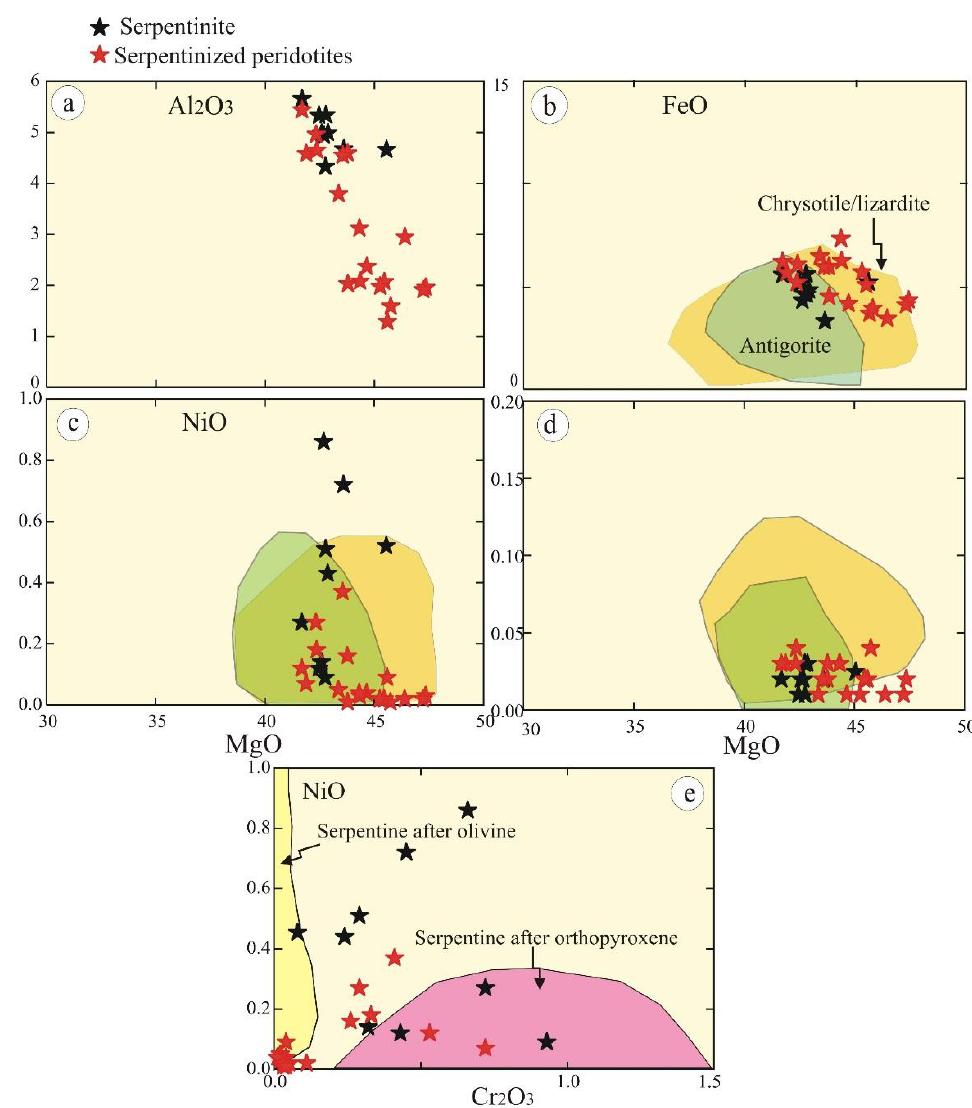
Figure 6. Serpentine binary variations: ( a ) MgO vs. Al 2 O 3 ; ( b ) MgO vs. FeO; (c ) MgO vs. NiO; ( d ) MgO vs. MnO; and ( e ) Cr 2 O 3 vs. NiO. Fields of antigorite and chrysotile are from [38]; serpentine after olivine and orthopyroxene fields are from [39].